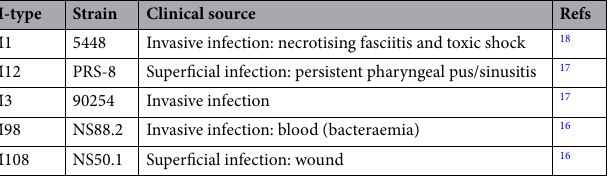
Table 2. GAS strains utilised in this study, their emm -types, and clinical